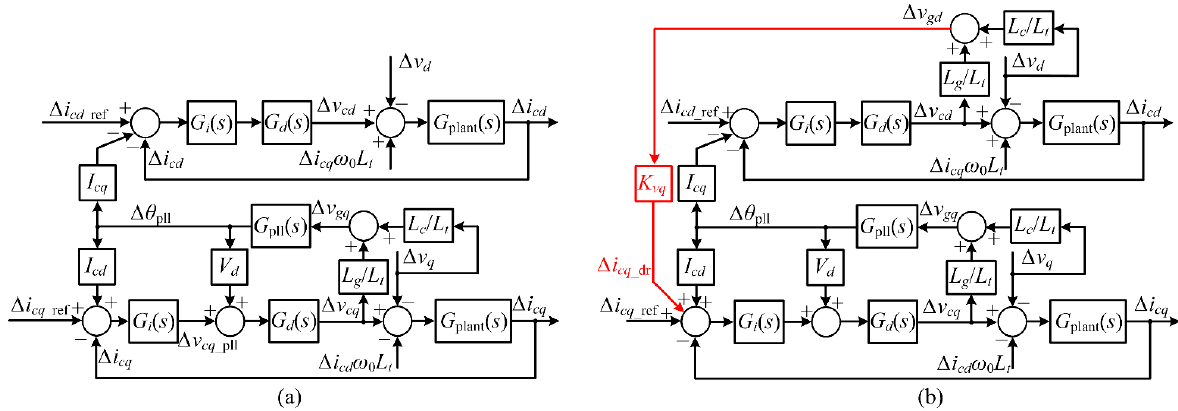
Figure 3. Control block diagrams of DSTATCOMs ( a ) without voltage droop; ( b ) with voltage droop. According to [26], the interactions between power converters and grids are mathemat- ically described